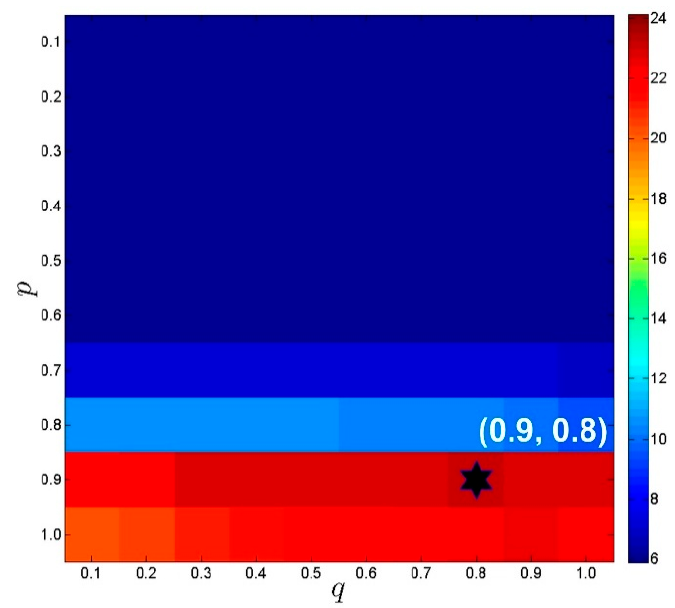
Figure 3. The influences of different parameters ( p , q ) on image reconstruction for axial cardiac dataset. The undersampled ( k , t ) -space measurements were generated using 12 radial projections. The optimal values of ( p , q ) were determined using the quality metric